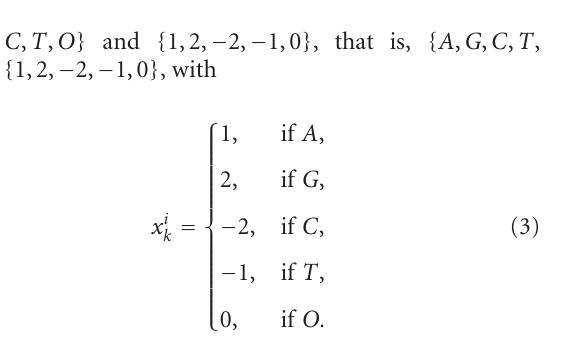
Figure 4: The order of taking measurements and applying chemical mutagens and radiation in a cell cycle.